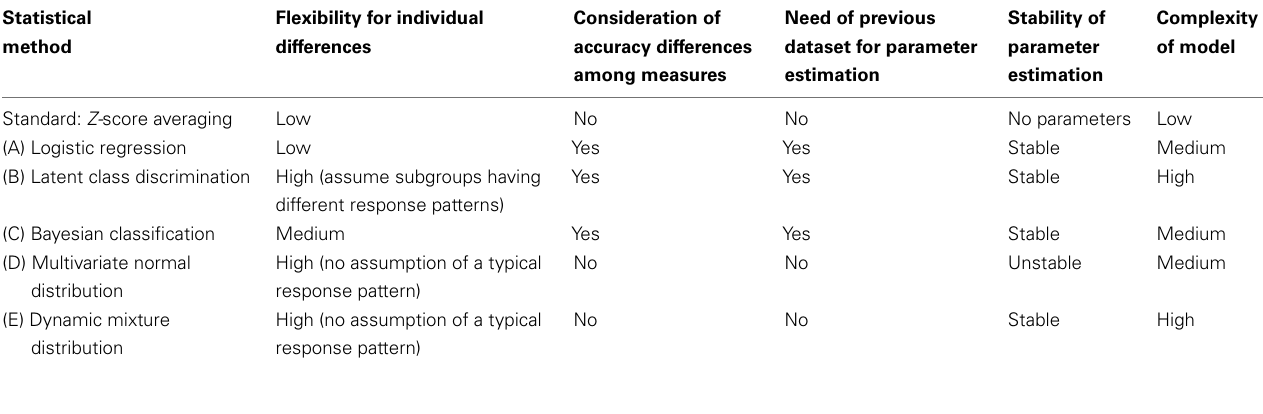
Table 1 | Comparison of statistical methods in terms of features that are important for field